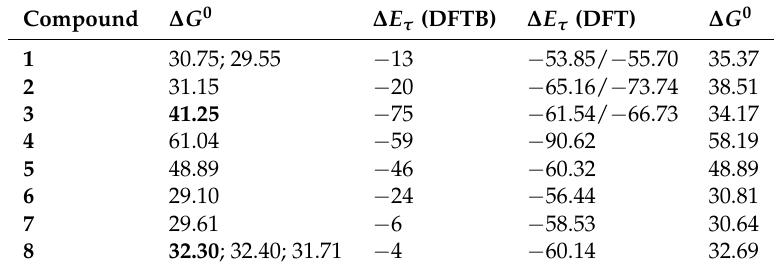
Table 2. Comparison between ∆ G 0 ( T = 298 K, P = 1 bar) for ionization of species RCH in